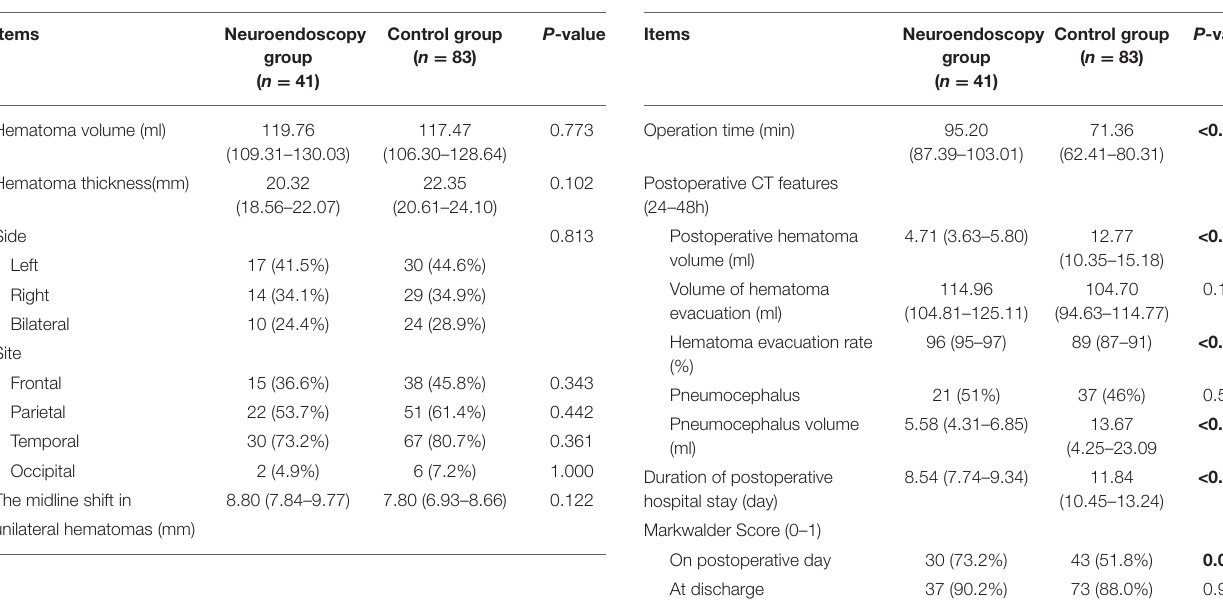
TABLE 2 | Preoperative CT features. TABLE 3 | Postoperative